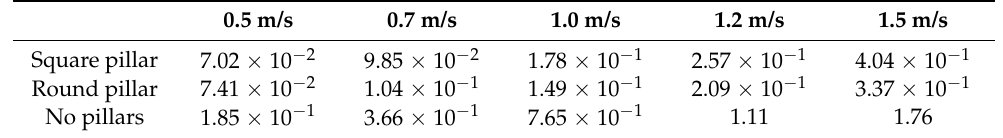
Table 3. Statistical table of maximum stress suffered by sediment unit: Figure 10. Relationship between the subsidence depth and the initial speed. Table 2. Statistical table of subsidence depth unit: mm.